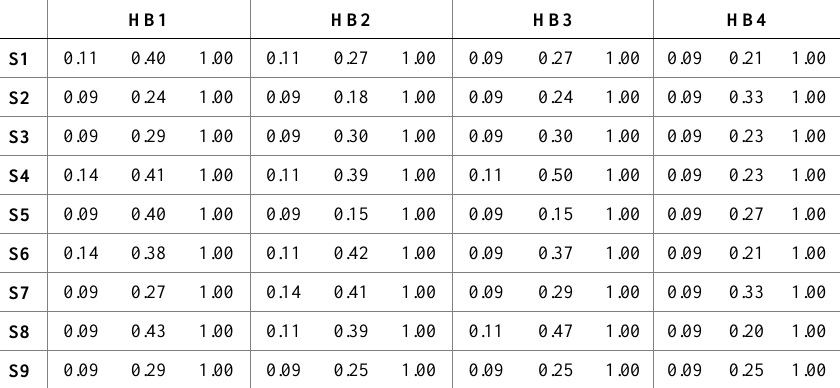
Table 11. Normalization Strategy Matrix for Obstacles to Process/Business Criteria